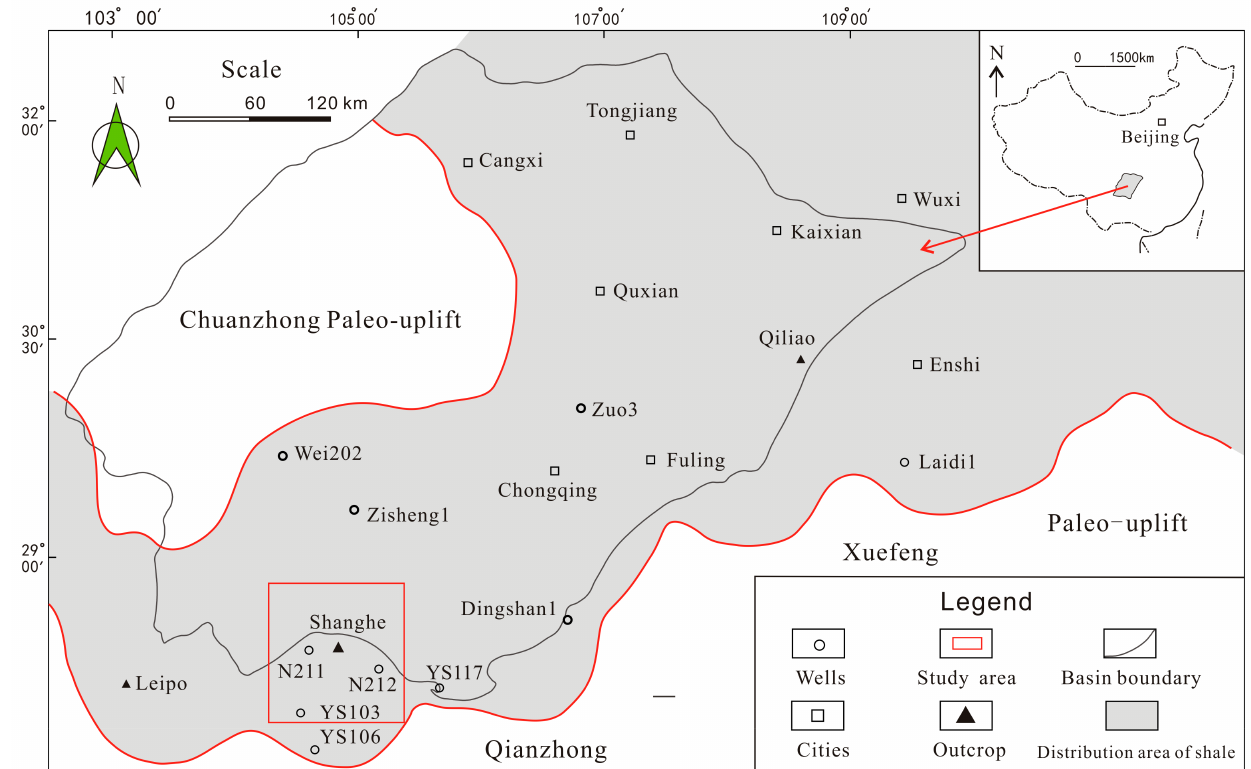
Figure 1. Map of the Sichuan Basin showing the distribution of the Wufeng–Longmaxi shale and locations of cored boreholes and outcrops. The base map is generated on Mou [43], and the locations of Chuanzhong paleo-uplift and Qianzhong–Xuefeng paleo-uplift are made based on Dong et al. [28]. The Wufeng–Longmaxi Formation intervals were formed in the Katian stage in the Upper Ordovician to the Telychian stage in the Lower Silurian and had a total thickness ranging from 240 to 410 m (Figure 2). Currently, the intervals constitute the most important shale gas exploration and development targets in China [30]. The Wufeng Formation, which underlies the Baota Formation at a parallel unconformity and has a thickness ranging from 0.5 to 10 m, is in conformable contact with the overlying Longmaxi Formation, which is successively overlain by the Shiniulang Formation [45]. Within the Wufeng Formation, thick black shales intercalated with multiple thin volcanic ash layers dominate the middle- to-lower regions [46]; limestones/marls with abundant Hirantian fauna fossils dominate the uppermost part of the formation [47]. Within the Longmaxi Formation, black, grayish thin-layered shales or massive shales dominate the lower regions, and grayish-green, to yellow-green shales occasionally intercalated with siltstone and argillaceous limestones comprise the upper regions of the formation